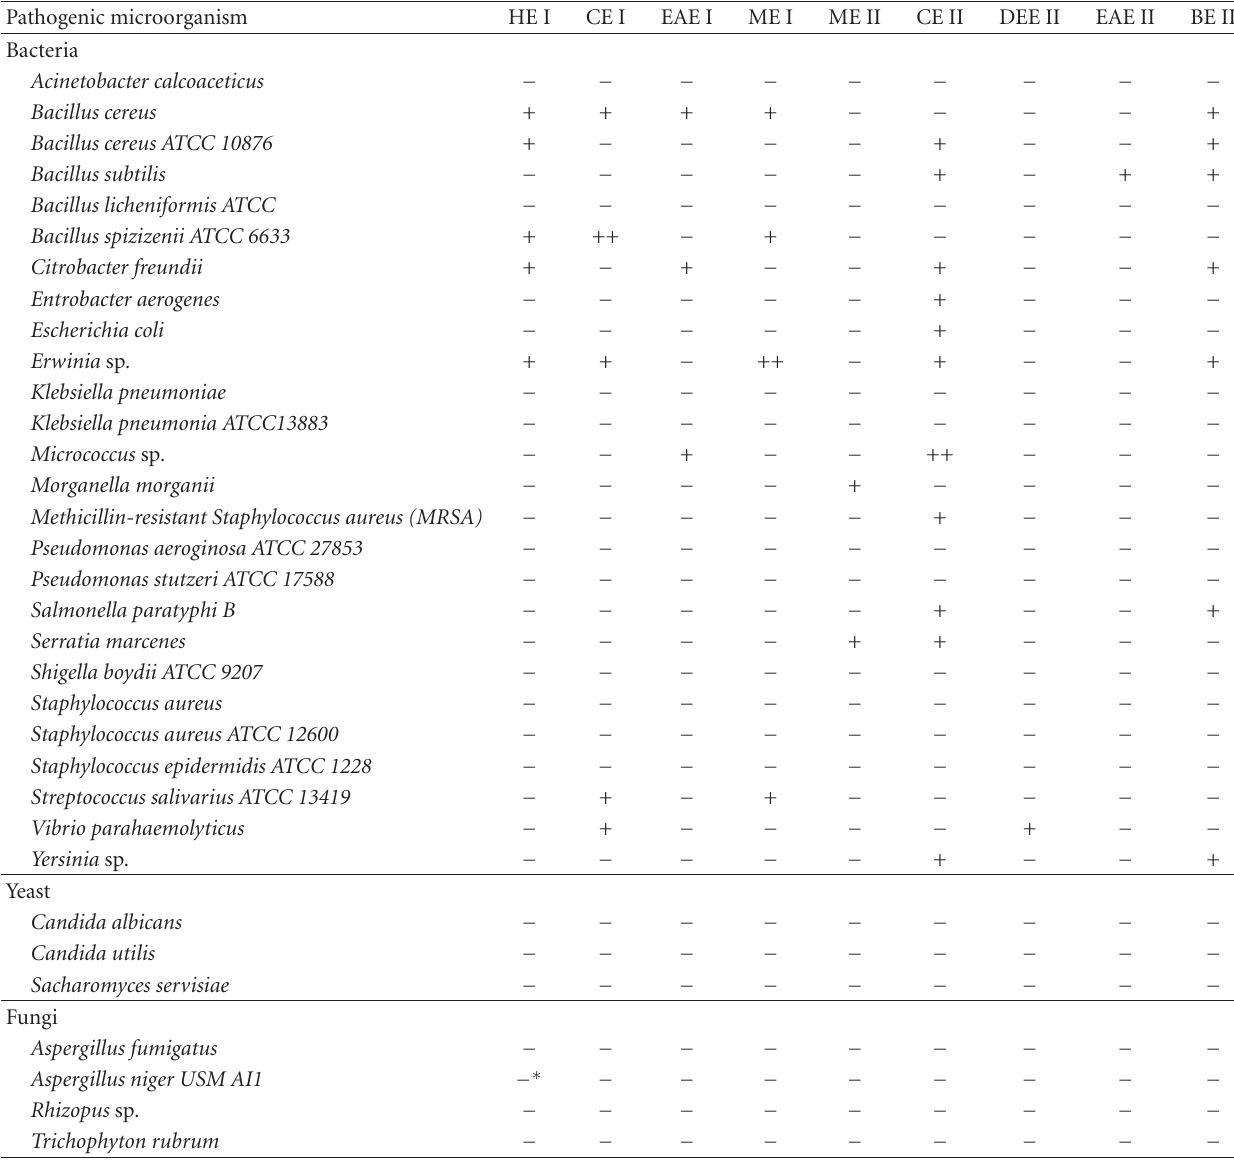
Table 2: Antimicrobial activity of Pilea